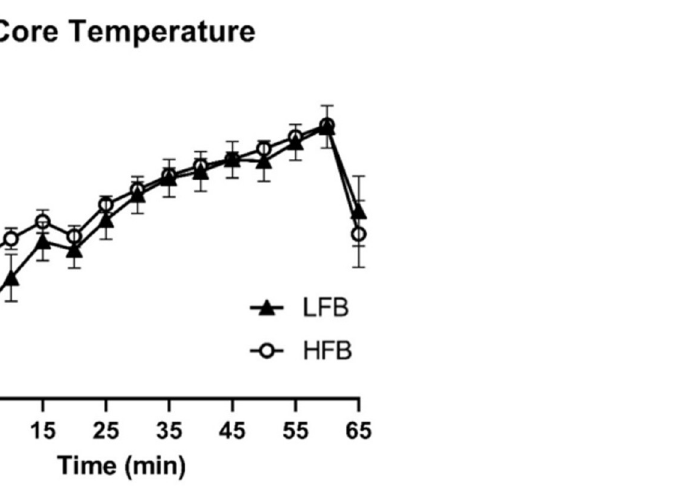
Fig 4. Core temperature during the 1h cycling trial.